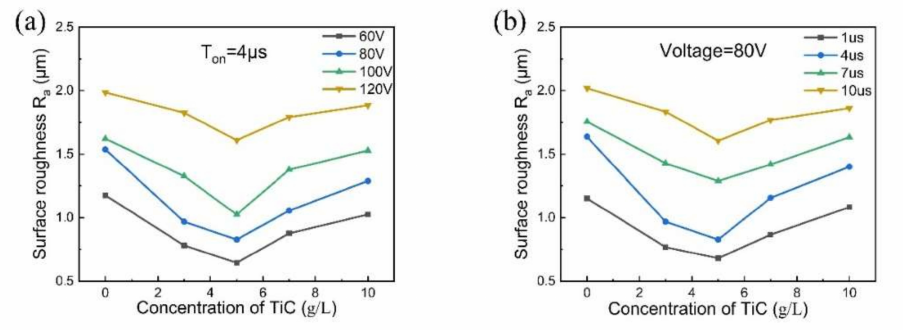
Figure 7. Surface roughness obtained with ( a ) di ff erent voltages and ( b ) di ff erent pulse durations in the TiC dielectric with TiC concentrations of 0, 3, 5, 7, and 10 g /